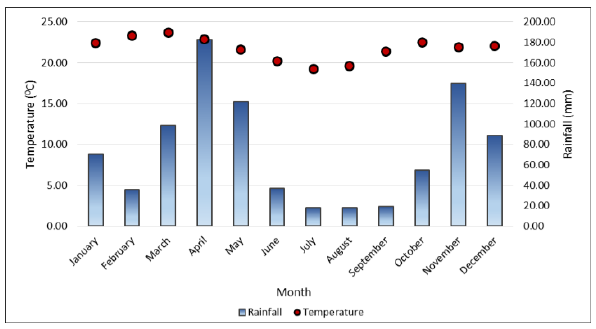
Figure 1: Mean monthly temperature and rainfall from Wilson Station, Nairobi